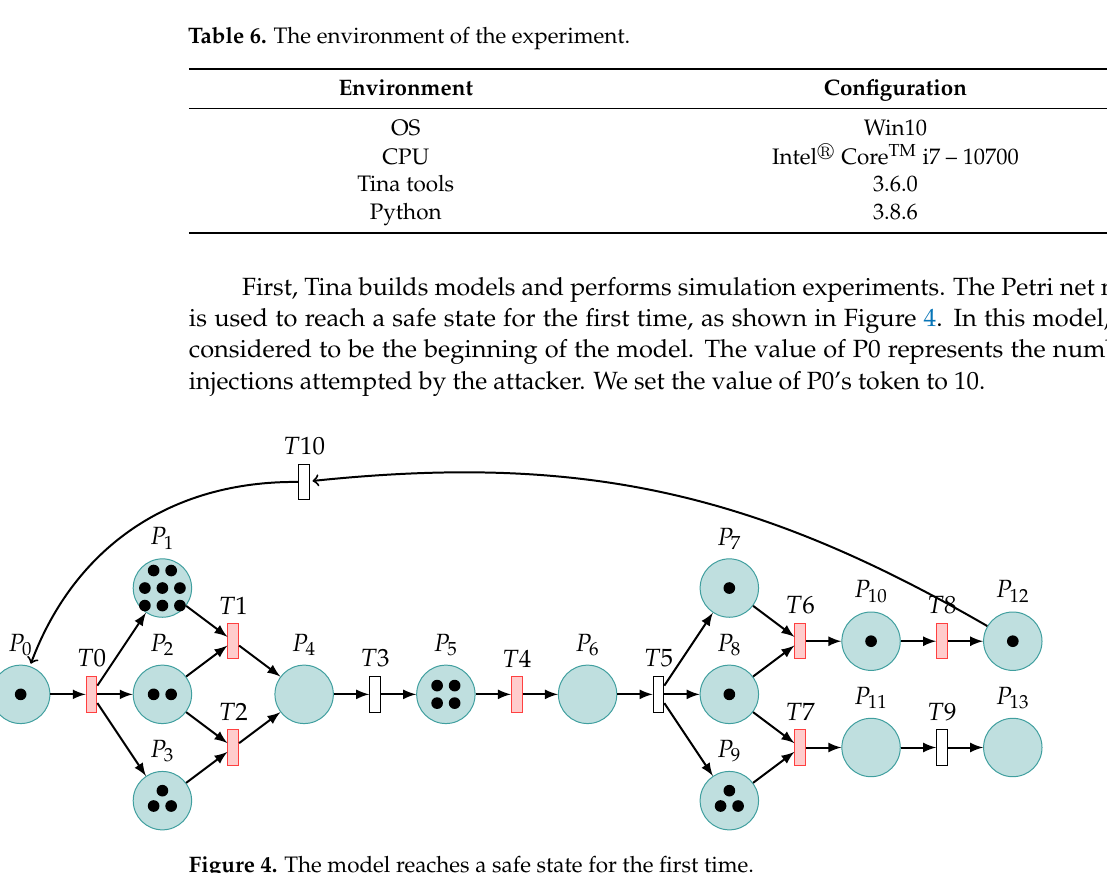
Figure 4. The model reaches a safe state for the first